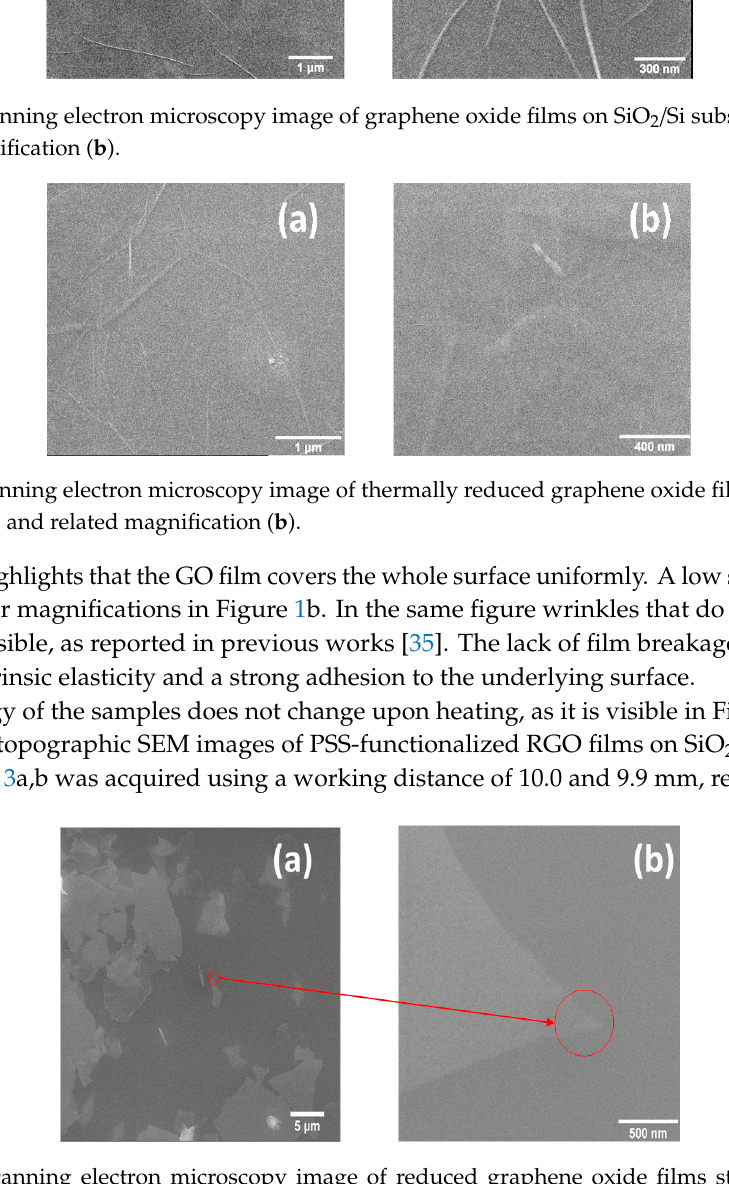
Figure 3. Scanning electron microscopy image of reduced graphene oxide films stabilized with poly(sodium 4-styrenesulfonate) (PSS) on SiO 2 /Si substrates ( a ) and related magnification ( b